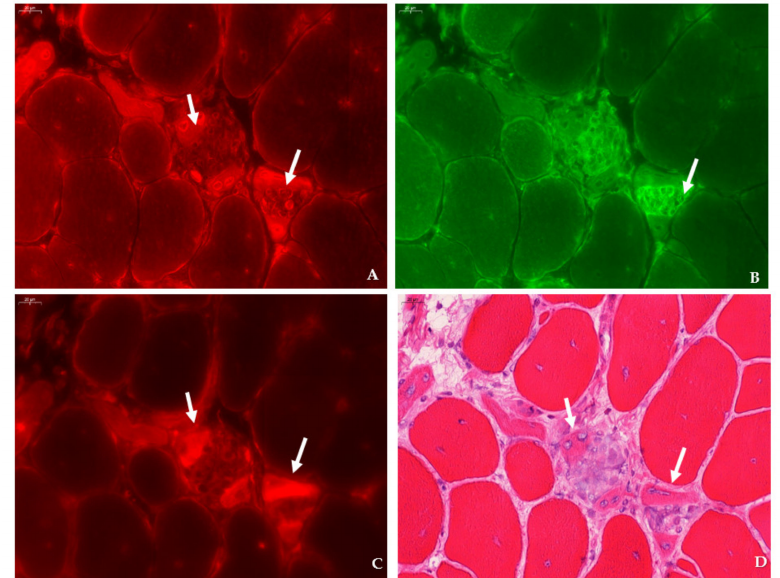
Figure 5. Expression of SMIT in relation to dystrophinopathy-associated pathology in consecutive sections of the tibialis anterior in a 12 week-old mdx mouse. ( A ) SMIT (CY3, red) is highly expressed in the membrane and the cytoplasm of a subset of myofibers (arrows). ( B ) Staining with F4/F80 antibody did not show the presence of F4/F80 macrophages situated in this field (AlexaFluor 488, green). ( C ) Staining with CD206 antibody (CY3, red) in the consecutive section was negative for type II macrophages. ( D ) Identification of fibers (arrows) in the same section that stained previously positive for SMIT in the double staining (SMIT/F4F80) show clear necrotic features in hematoxylin–eosin section. Scale bars = 50 µ m.